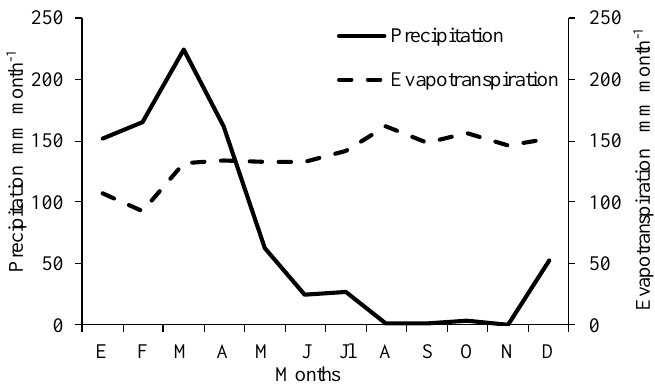
Figure 1. Water balance in the INIAP-EEP, 2009–2017. The solid line represents the monthly average of precipitation and the dashed line the potential evapotranspiration.